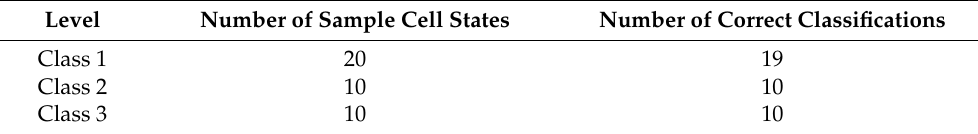
Table 3. Evaluation results of the status of aluminum electrolytic cells.